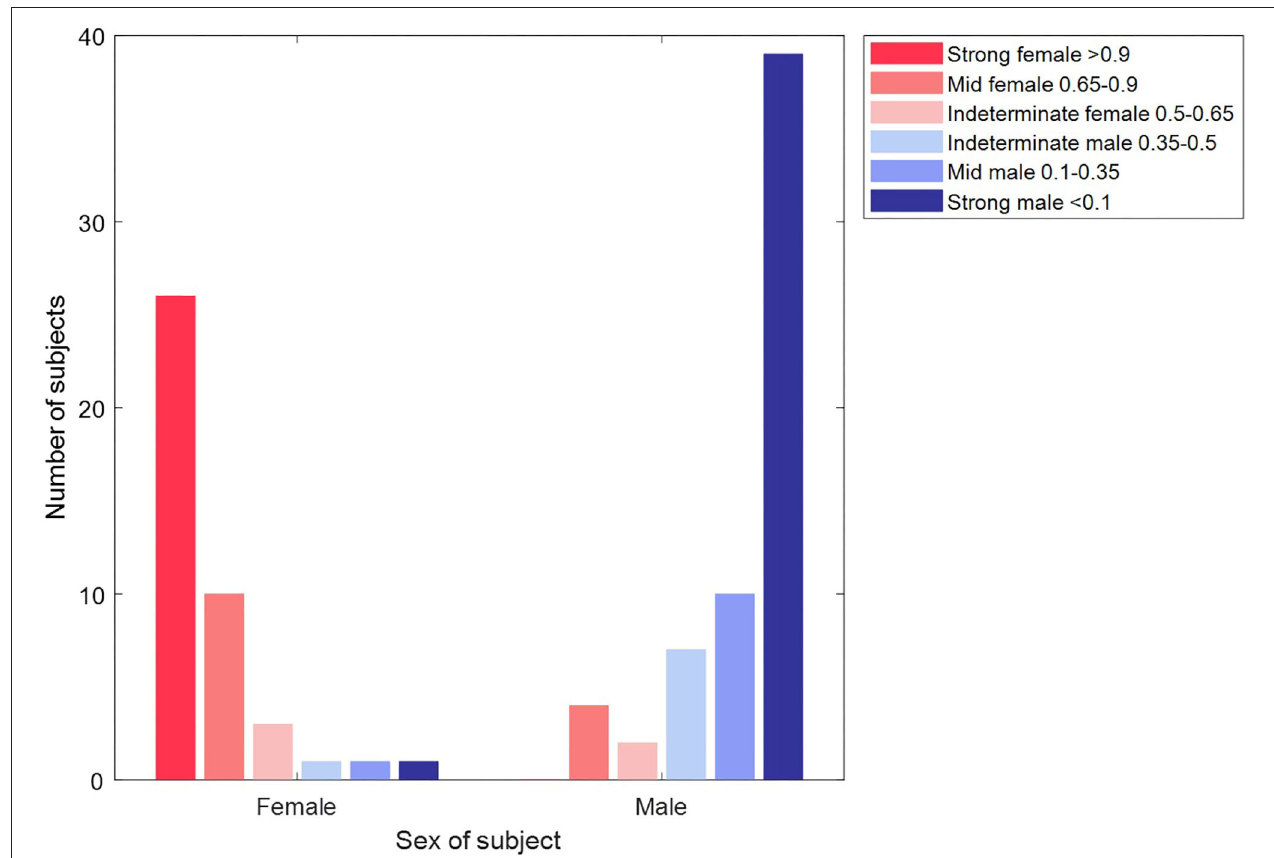
FIGURE 10 | Classification of unseen records in Dataset 2 by sex and classification category. The plot shows the classification of each of the 104 subjects of Dataset 2. The majority of subjects (39/42 females in the red bars and 56/65 male subjects in the blue bars) are classified correctly. Furthermore, the majority (65/95) of these correct classifications are made with a “strong”